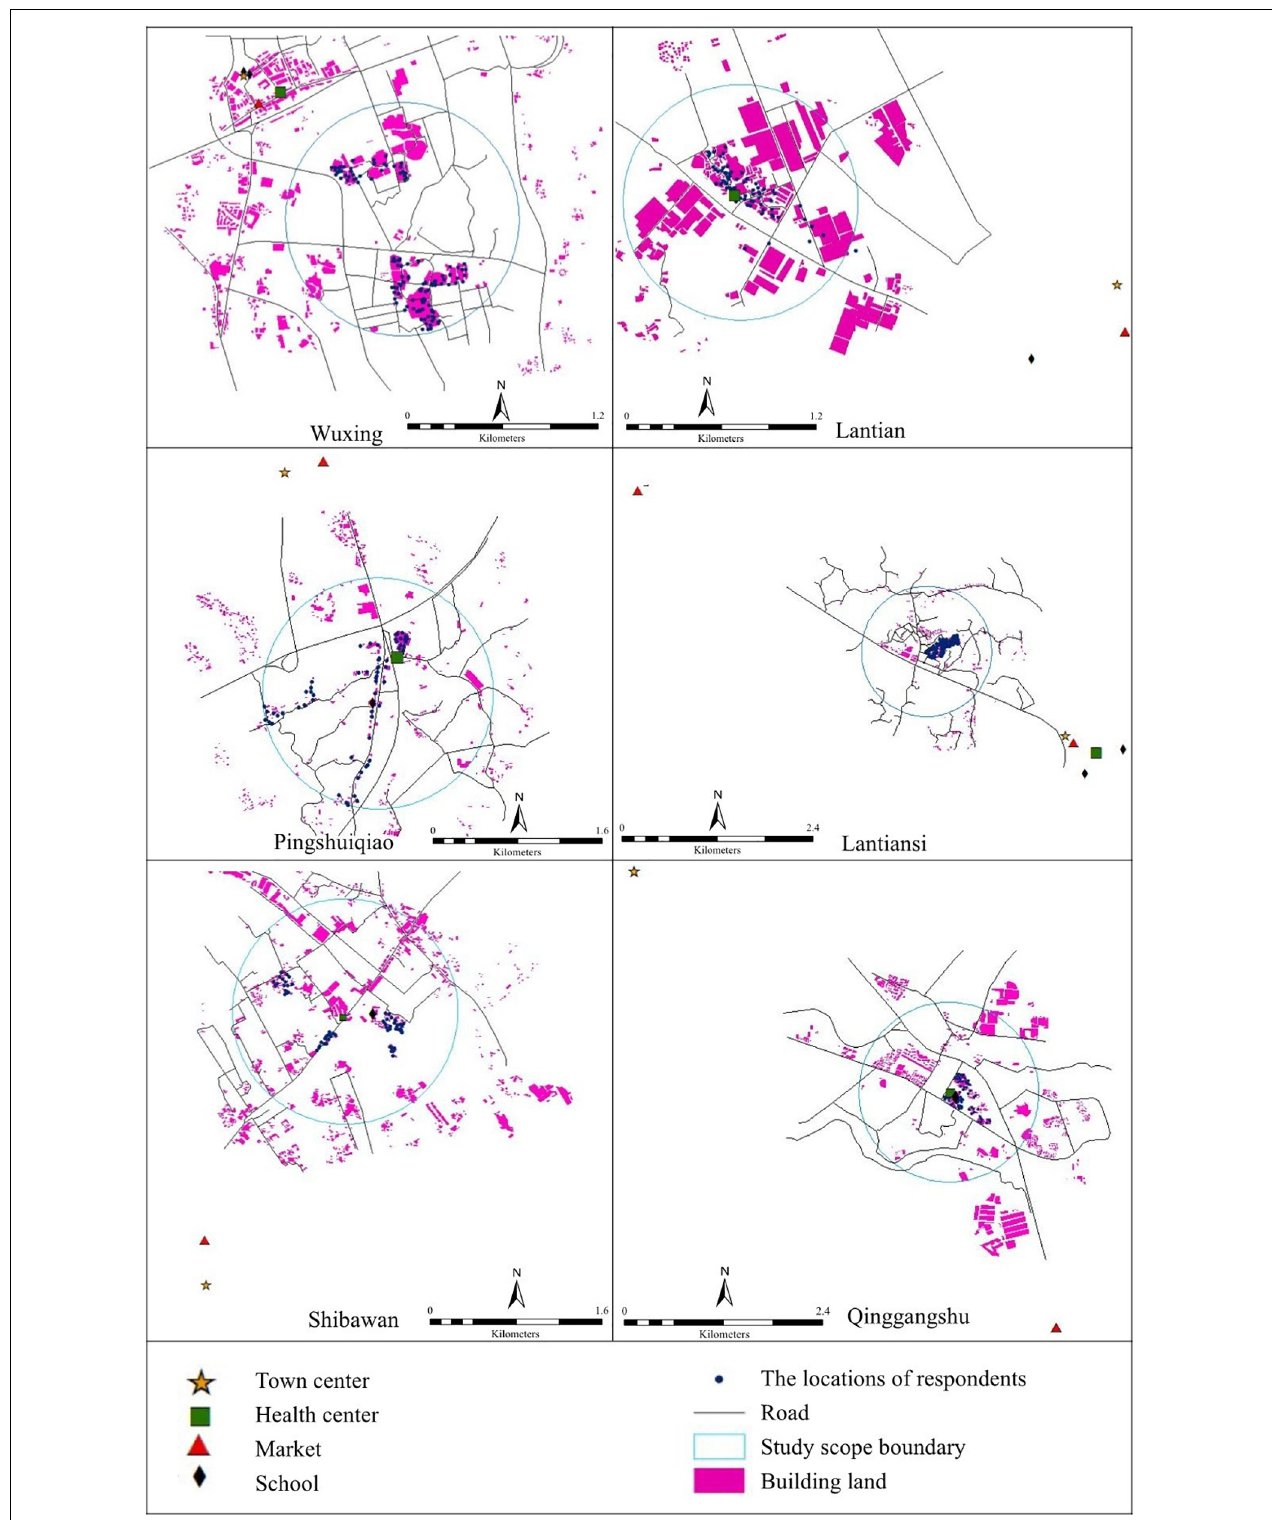
FIGURE 6 | Distribution of respondents, buildings, and